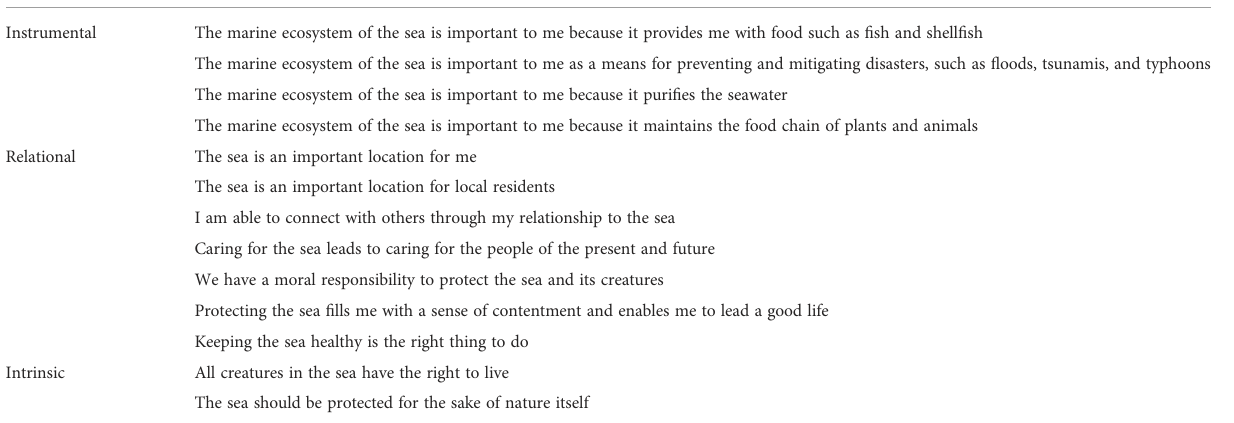
TABLE 2 Value statements of instrumental, relational, and intrinsic values. Value